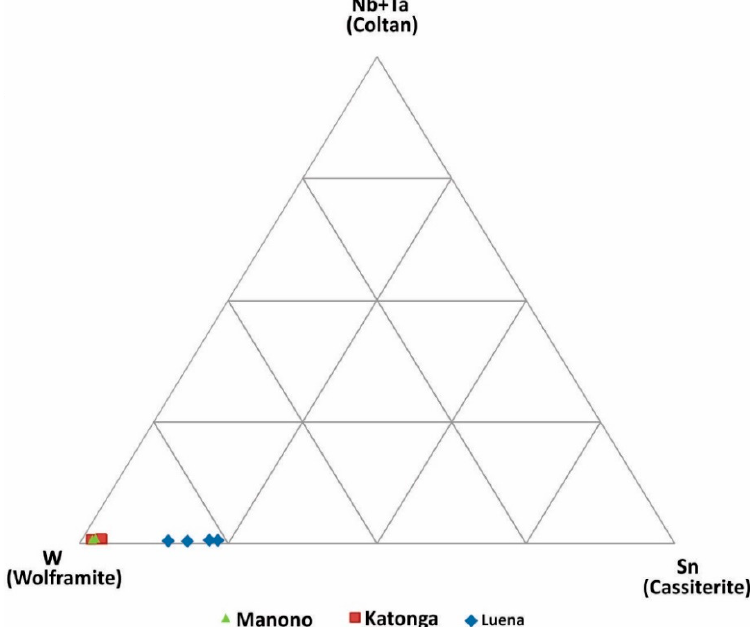
Figure 6. Discrimination of wolframite ore samples based on W, Sn and Nb+Ta concentrations.